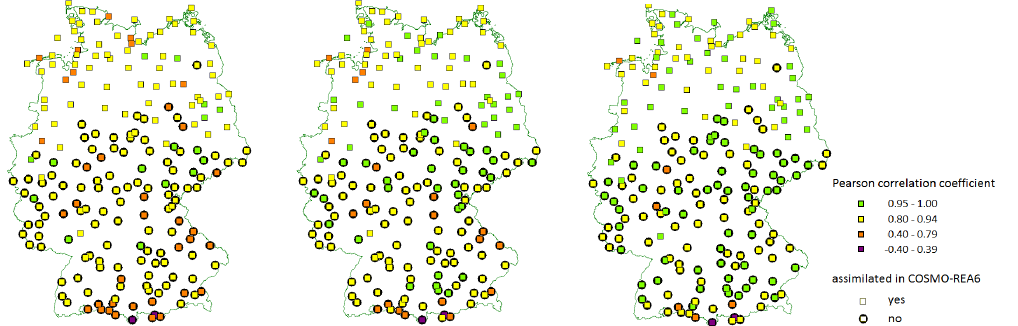
Figure 8. Pearson correlation coefficient of monthly mean wind speeds (calculated from daily wind speeds) between station observations and reanalyses: ERA-20C (left), ERA-Interim (middle), and COSMO-REA6 (right). Stations not assimilated in COSMO-REA6 are highlighted with grey circles.